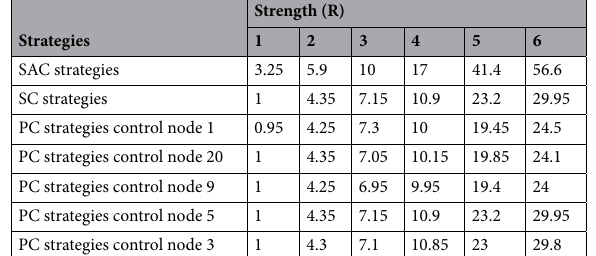
Table 6. Comparison of the NFT-Average of network stability restoration under different control strategies.